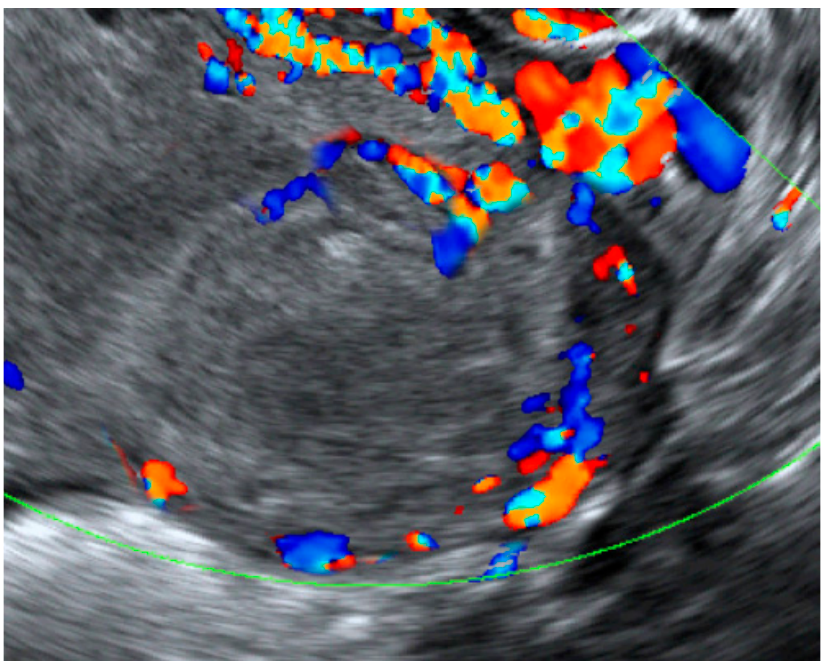
Figure 4. Color flow ultrasound of the same mass at a follow-up ultrasound at 37 weeks of gesta- tion shows changes in the active flow of the cyst, now as an inactive hemorrhagic heterogeneous mass without internal color flow, even at the low PRF setting, as presented in Figure 4. The finding suggested that the aneurysm had become thrombotic. Cesarean section was performed at 39 weeks of gestation because of a breech presentation, giving birth to a healthy female newborn with Apgar scores of 8 and 10 at 1 and 5 min. The operative finding revealed the unruptured thrombotic an- eurysm close to the right uterine isthmus and cardinal ligament. The thrombotic uterine artery was approximately 4 cm in length and 1 cm in diameter with a saccular-like area of 2 cm in width con- nected to the uterus. The patient had an uneventful postpartum period but did not attend a fol- low-up at 6 weeks postpartum. Clinical Impact . An unruptured true aneurysm of the uterine ar- tery can be detected by one of the following techniques: (1) Color Doppler ultrasound finding an intrauterine mass or a mass connected to the uterus with swirling blood flow, with a to-and-fro pattern; (2) magnetic resonance imaging (MRI) revealing an enhanced, sac-like structure within the uterus or connected to the uterus; (3) computed tomography angiography (CTA) confirming the presence of sac-like structure with a connection to the uterine artery. Preoperatively, differentiating a true aneurysm from a pseudoaneurysm may be based on the presence of a prior history of trauma or infection, pelvic surgery or cesarean section. Nevertheless, definite diagnosis relies on either finding intact vascular wall layers in the operative field or pathological discovery. A uterine artery pseudoaneurysm or arteriovenous fistula, probably also a true aneurysm, is usually detected after the rupture of lesions, resulting in a spontaneous massive hemorrhage or after uterine curettage [9]. Pathologically, pseudoaneurysms usually consist of only one layer of loose connective tissue, dif- ferent from true aneurysms which consist of a complete three-layered wall. Extraluminal swirling blood flow can lead to the enlargement of the pseudoaneurysm, making it susceptible to rupture and serious bleeding. The natural course and prognosis of true aneurysms are not known. How- ever, it should be considered a serious condition and a difficult cesarean section in the category of laceration or organ damage [10], which can cause massive hemorrhage, leading to a life-threatening scenario. Knowing in advance the potential surgical difficulties allows the surgeon to plan the best strategies. Nevertheless, theoretically, true aneurysms may be less susceptible to rupture than